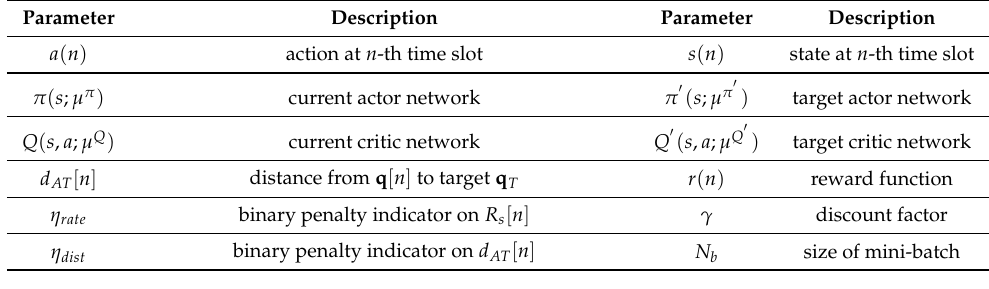
Algorithm 1 DDPG